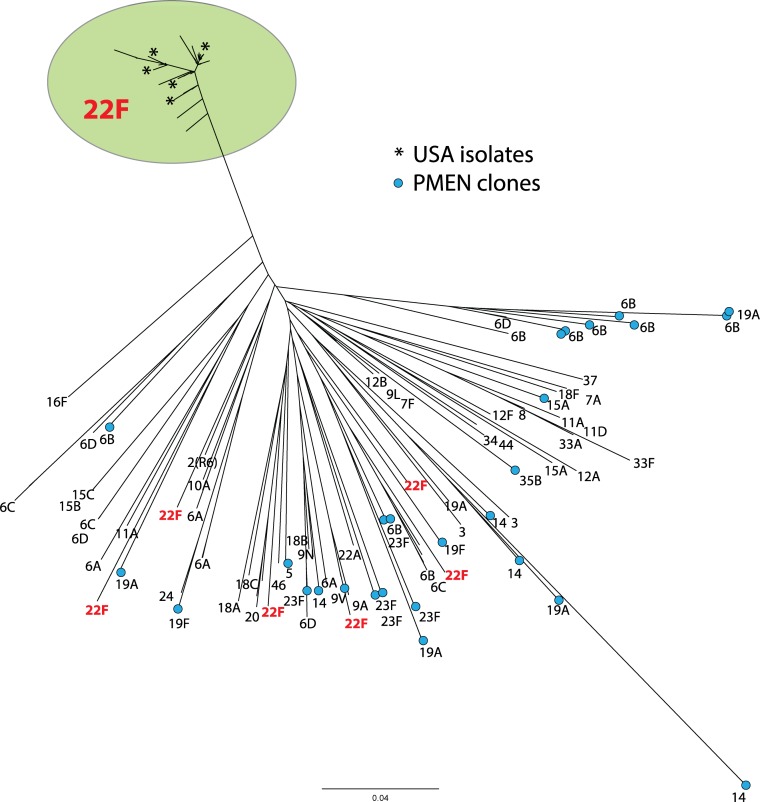
Core SNV phylogenetic comparison of genetic relatedness of Streptococcus pneumoniae serotype 22F.Node labels indicate serotype, an asterisk indicates USA strains and blue nodes indicate Pneumococcal Molecular Epidemiology Network (PMEN) clones. The length of the scale bar represents the estimated evolutionary divergence between isolates on the basis of average genetic distance between strains (estimated number of substitutions in the sample / total number of high quality SNVs).